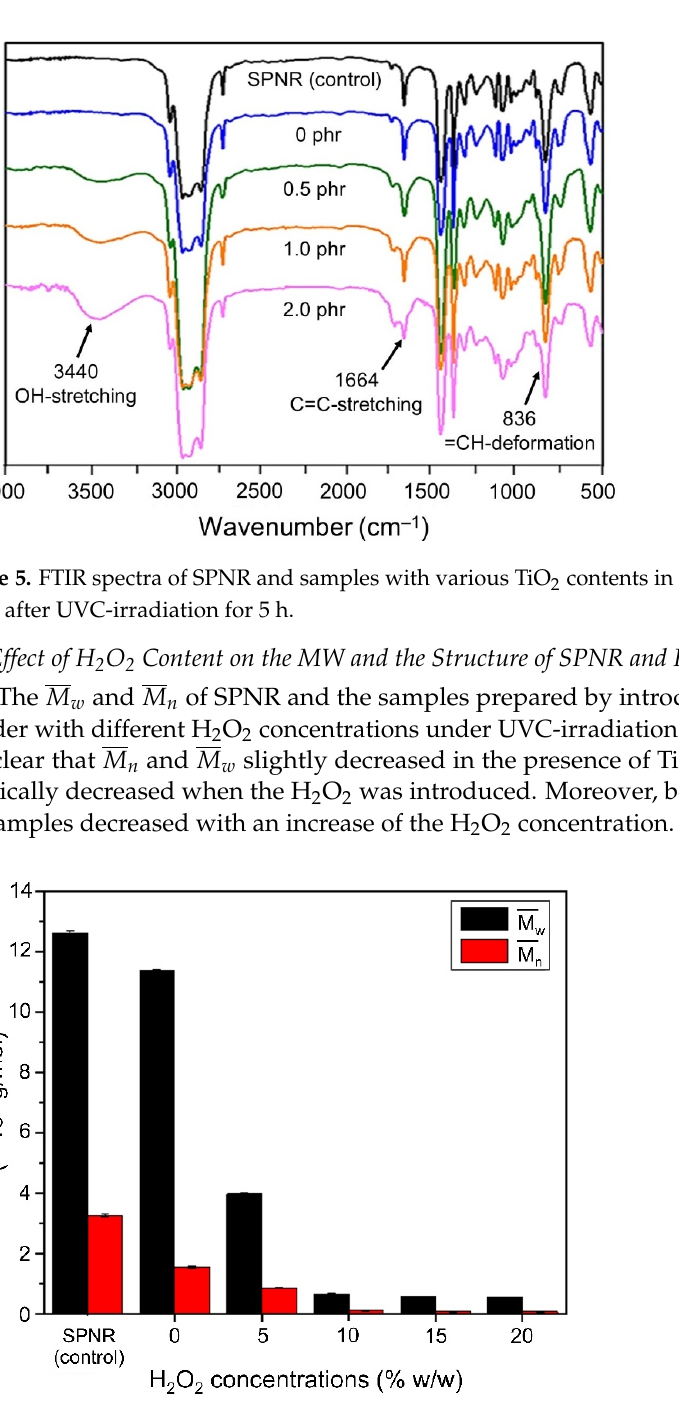
Figure 7. FTIR spectra of SPNR and the samples prepared by introducing 2.0 phr of TiO 2 powder with various H 2 O 2 concentrations after UVC-irradiation for 5 h. 3.4. Effect of UVC-Irradiation Time on the SPNR and FLNR Structures